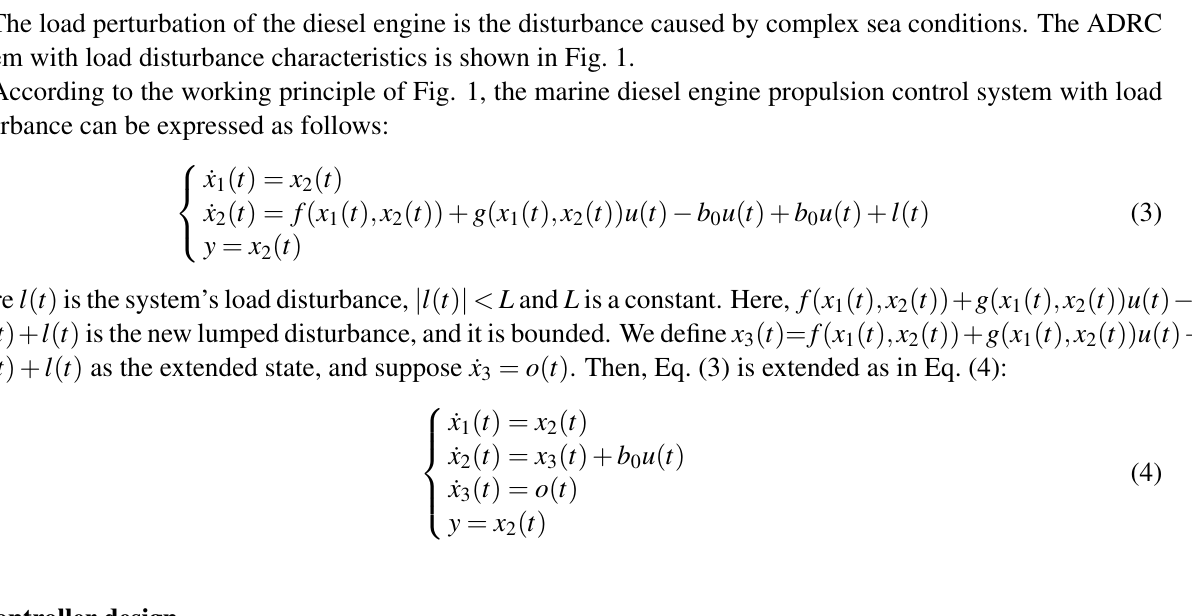
Fig. 1 The propulsion control system with load